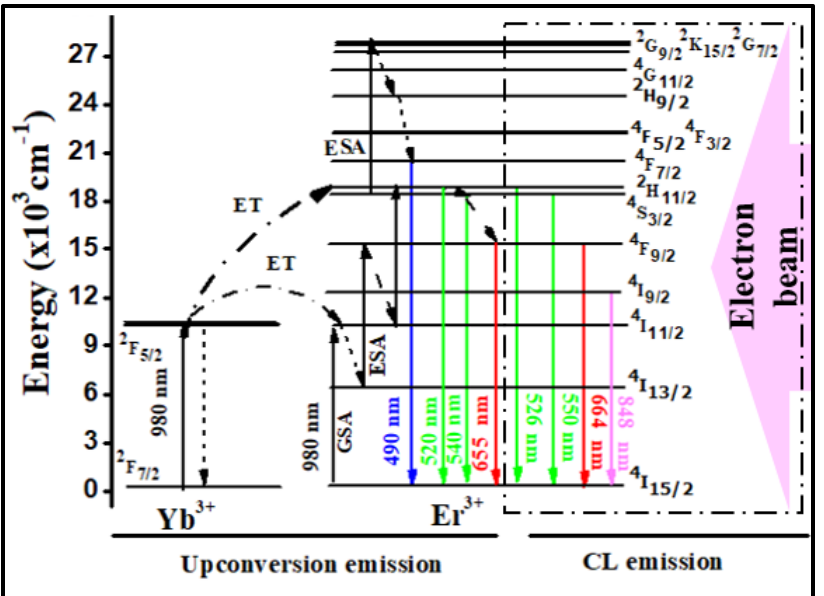
Figure 7. Energy level pathways for upconversion emissions bands of Yb 3+ (sensitizer) and Er 3+ (activator) with possible excitation for NaGdF 4 : Er 3+ /Yb 3+ upconversion phosphor particles. Along the side, we explain the CL emissions due to the excitation of canal rays.